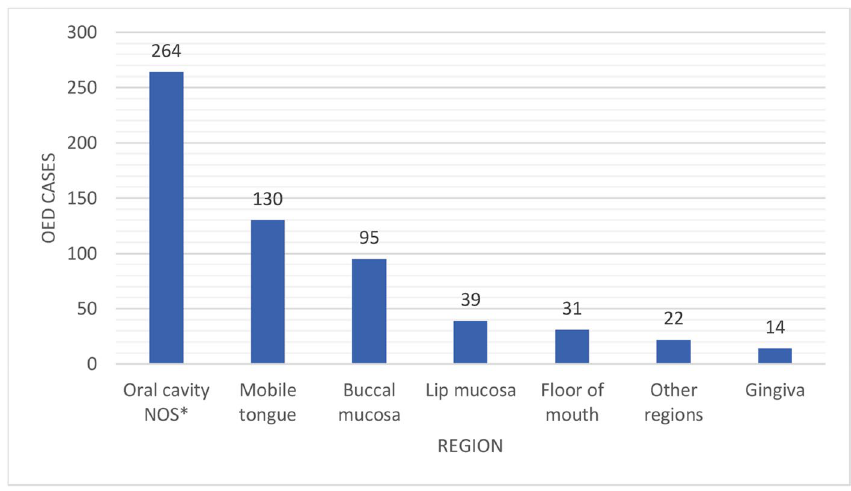
Figure 1. Location of oral epithelial dysplasia (OED) cases in the oral cavity (* NOS not otherwise